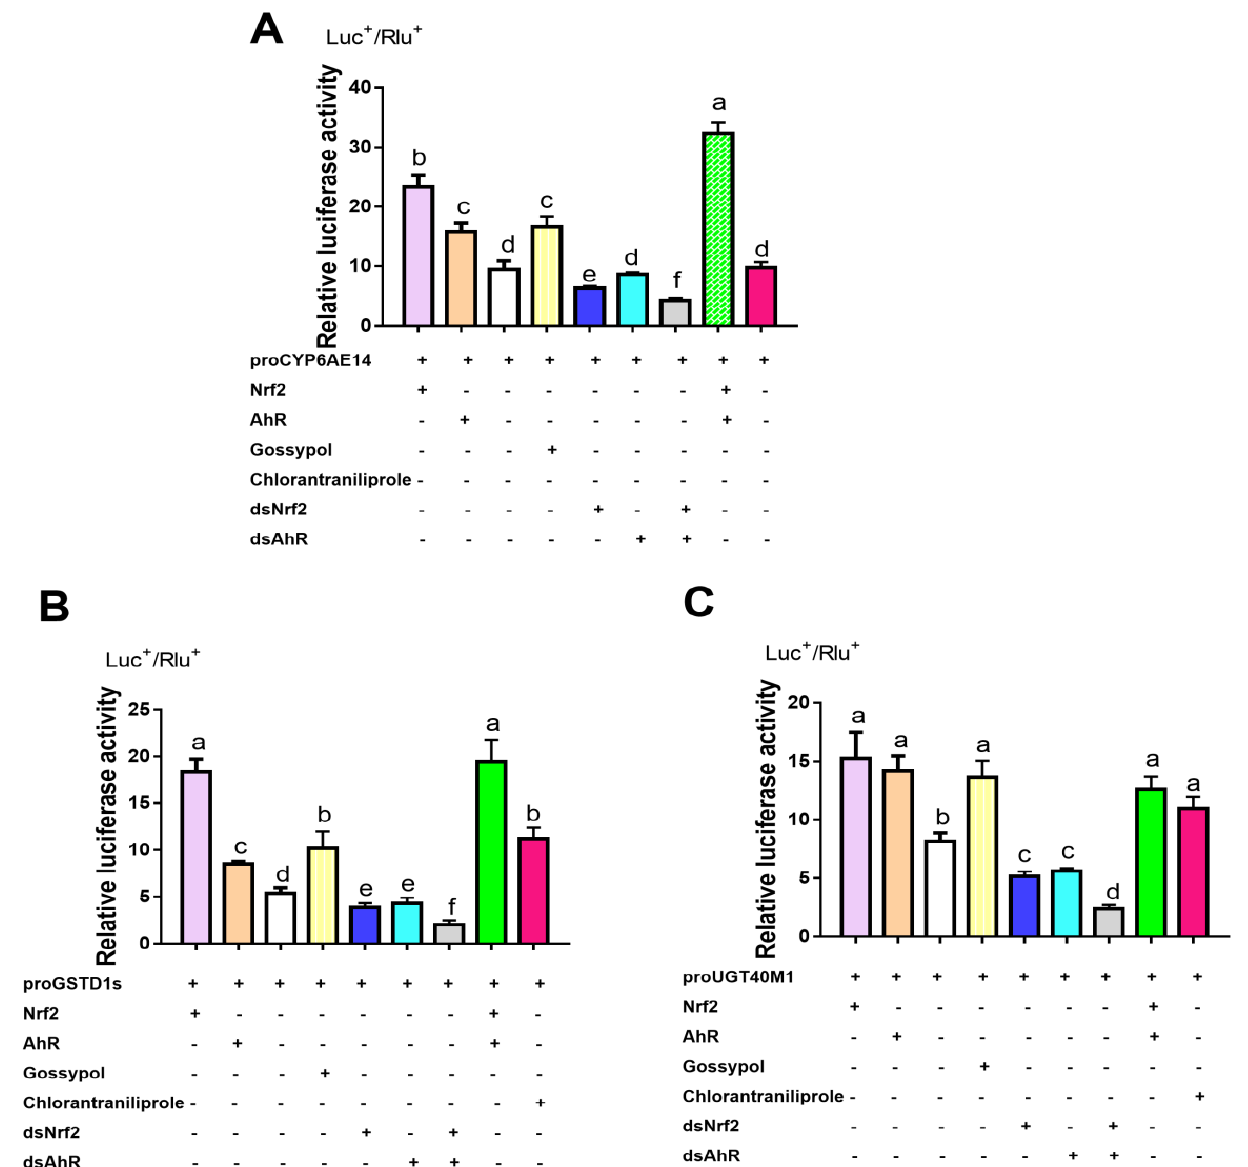
Figure 6. Different xenobiotics (gossypol and chlorantraniliprole) induced the promoter activity of CYP6AE14 ( A ), GSTD1s ( B ) and UGT40M1 ( C ) genes, which also transiently transfected with dsNrf2, dsAhR, HaAhR or HaNrf2. Different letters on error bars show significant differences ( p < 0.05). After H. armigera fat body cells were transfected with the pAcV5His-Red-HaNrf2 construct for 24 h, the subcellular localization of HaNrf2 was observed. We found that HaNrf2 was mainly located in the cytoplasm with the red florescence (Figure 7B). These fat body cells were then treated with 2-tridecanone in a final concentration of 125 µ M for 4 h. We observed that the subcellular localization of Nrf2 was mainly in the nucleus following 2-tridecanone treatment (Figure 7B), while the control cells treated with ethanol still had signals indicating that Nrf2 was localized to the cytoplasm (Figure